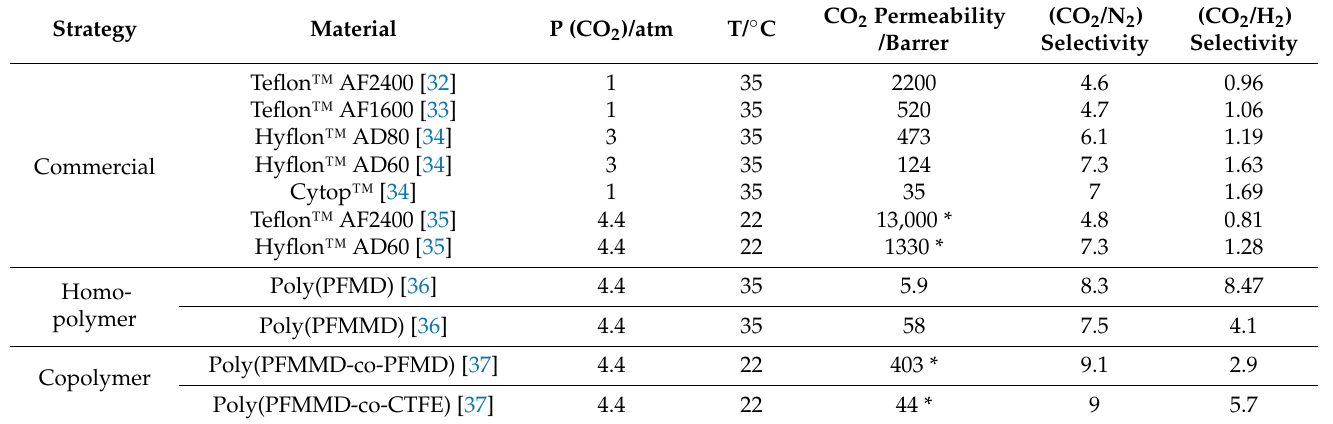
Table 3. Transport properties of specific